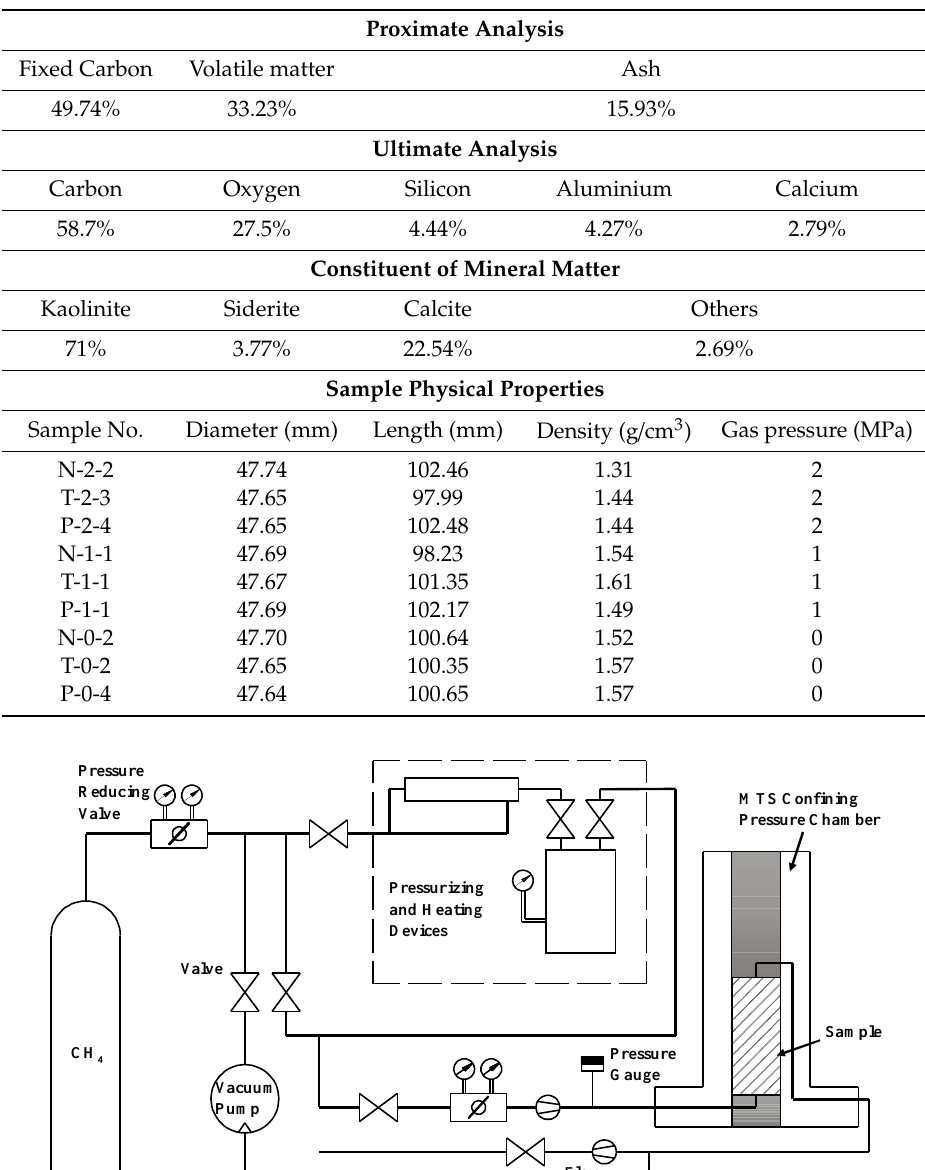
Table 2. Properties of the Tashan bituminous coal samples.